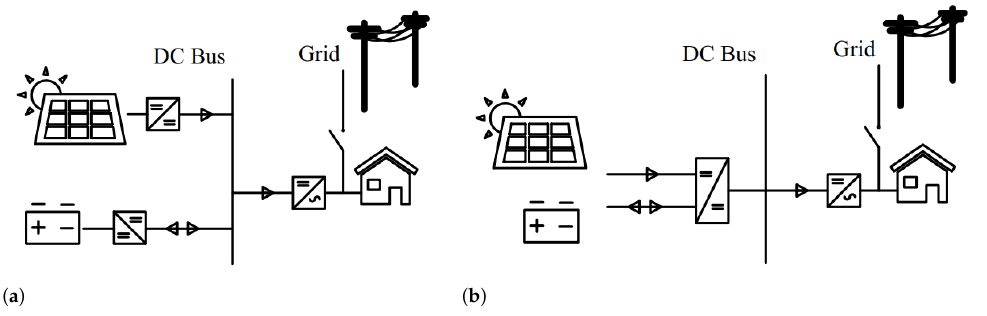
Figure 1. Diagram of multi-stage hybrid renewable energy grid-connected system: ( a ) Classical type. ( b ) Integrated